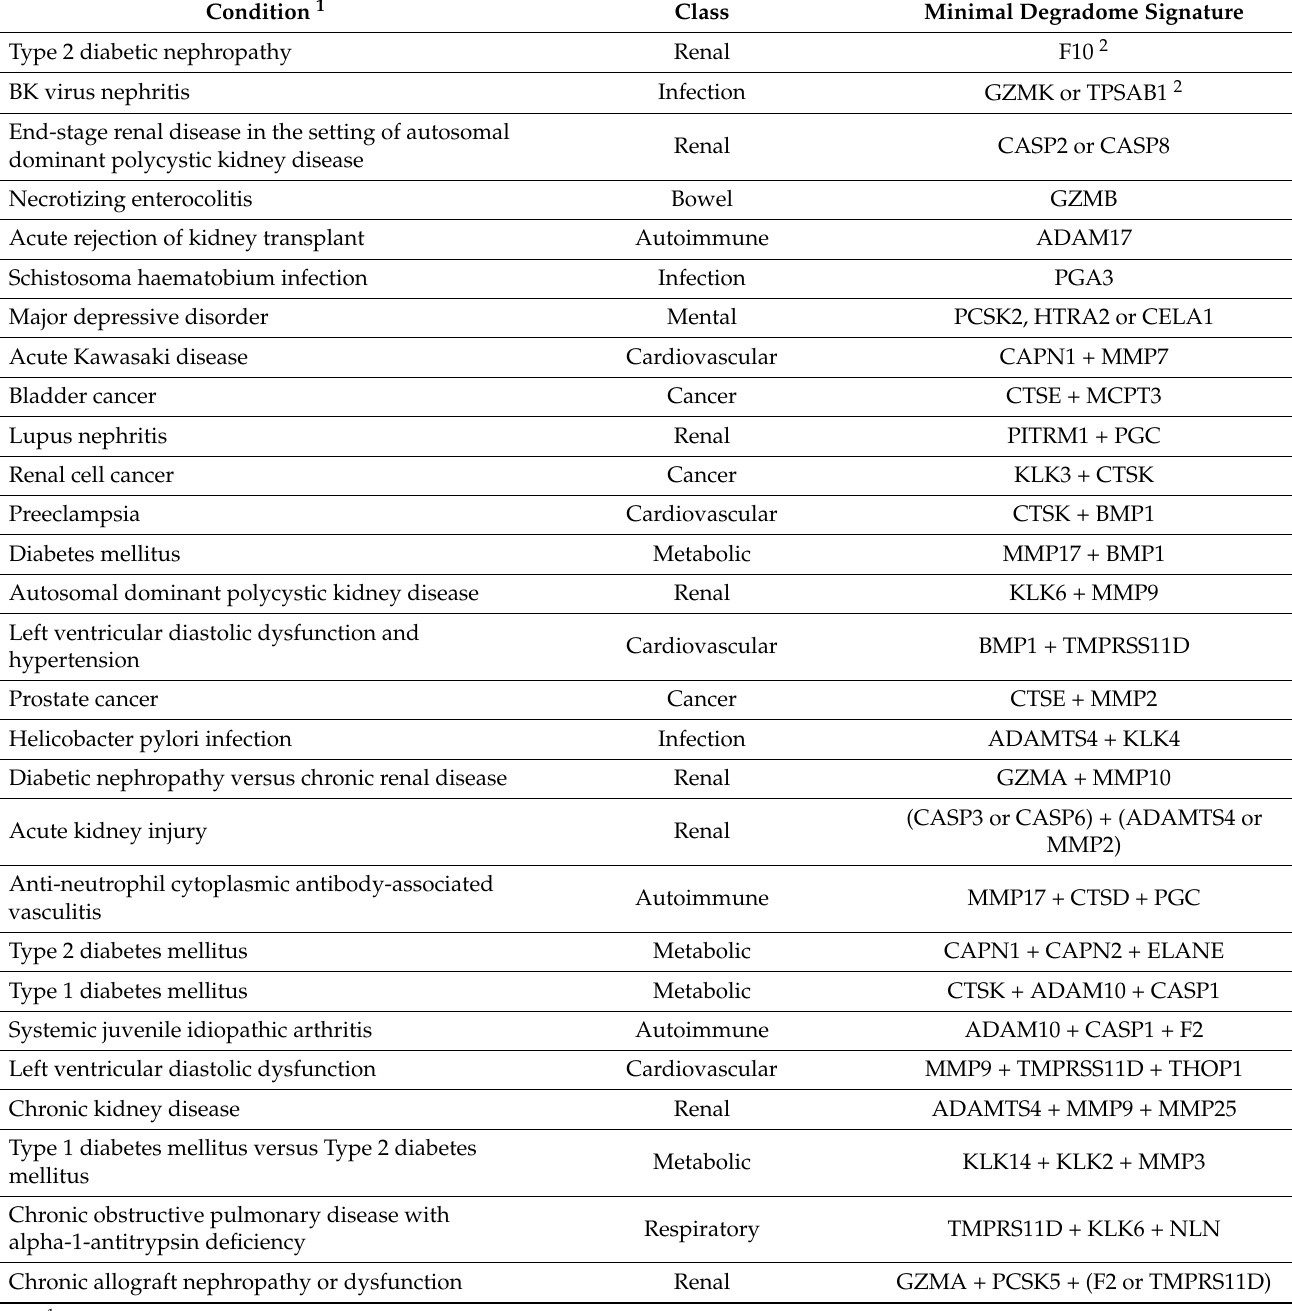
Table 1. Putative minimal degradome signature for all conditions studied through urine